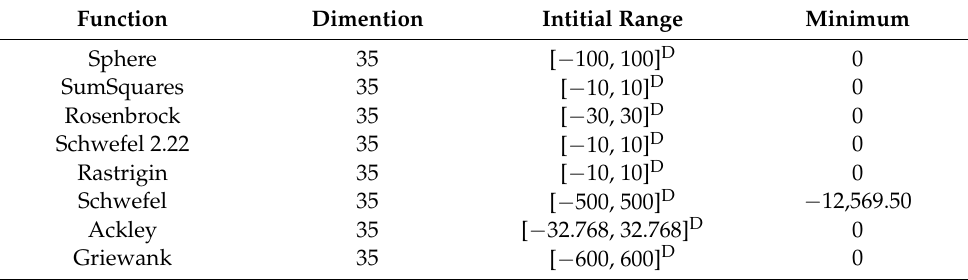
Table 2. Parameters of the benchmark function.